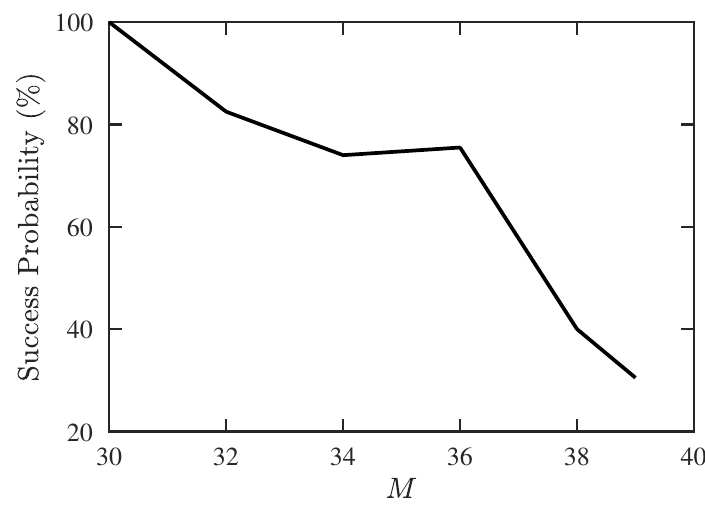
Figure 7. Success probability of DOA and CF estimation with proposed PJE algorithm, under different numbers of signal sources, SNR = 10 dB, Q = 300, M u = 10.